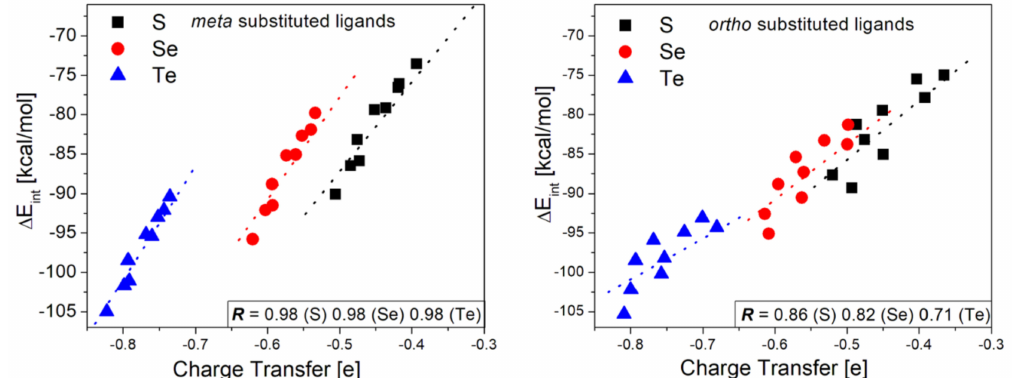
Figure 6. Plot of the amount of charge transferred to the gold substrate from the phenyl-chalcogenolates functionalized in meta ( left ) and ortho ( right )